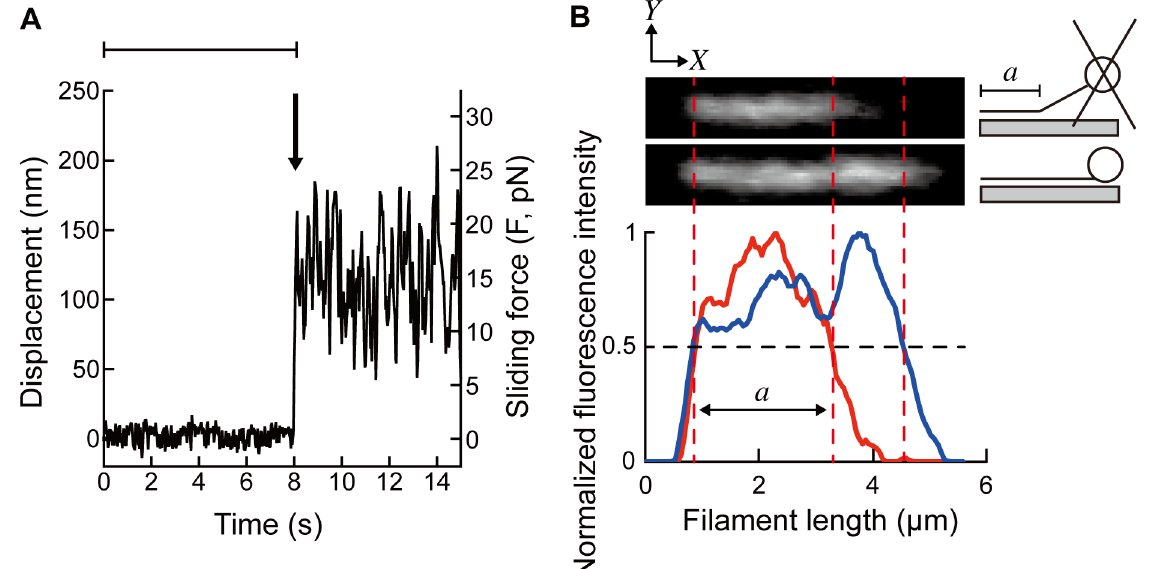
Fig 4. Analysis of sliding force and filament length. (A) A representative time course of the bead displacement during measurement. At first, a bead-tailed reconstituted thin filament ( a = 3.3 μ m) was trapped in the activating solution, where the displacement of the bead is defined as 0 (the bead is at the trap center) because there is no interaction between the thin filament and HMM (during the period shown by a horizontal line). Then, the coverslip was elevated to the focal plane of the fluorescence microscopy, which is below the focal plane of the bright-field microscopy and the focus of the optical tweezers. When the thin filament started to interact with HMM on the coverslip, the bead was displaced away from the trap center (arrow). To calculate the sliding force in the X-Y plane, the displacement was multiplied by the trap stiffness. (B) Representative fluorescence images of the same bead-tailed actin filament trapped (upper photo) and released (lower photo), and the result of their intensity analysis. While the bead is trapped above the glass surface, only a part of the actin filament interacting with HMM on the coverslip was visible under the TIRF microscopy. Therefore, the actin filament appears shorter when the bead is trapped (upper photo) than when it is released (lower photo). Fluorescence images shown are the region of interest (ROI) within which the fluorescence intensities were averaged along the columns in Y -axis to produce the 1D intensity profile along the X -axis (red and blue curves correspond to the upper and lower fluorescence micrographs, respectively). Background signal was determined from the other ROI (set next to the actin filament) which was subtracted from the signal of the actin filament. Frequently, the background was none. The parameter ’ a ’ as defined in Fig 1 was determined as the distance between the points where the fluorescence intensity was half of the maximum (bottom).